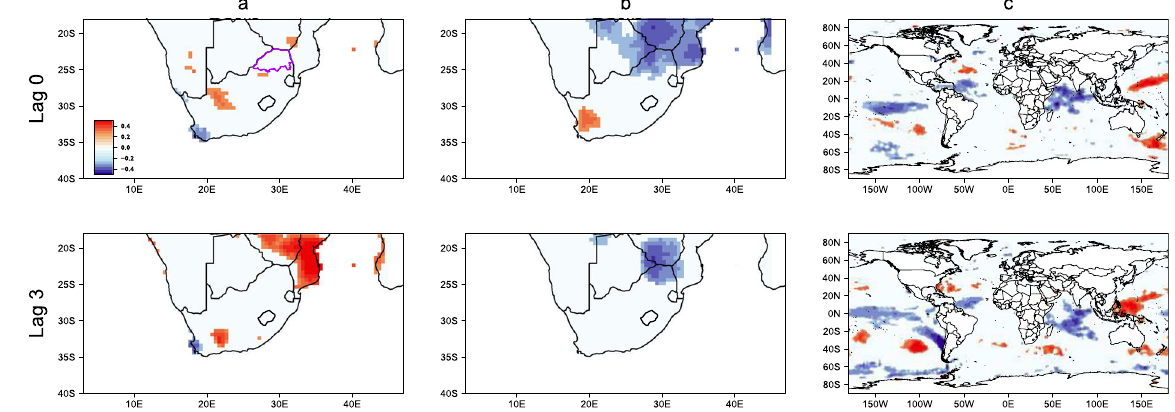
Figure 3. Correlation maps of seasonal malaria incidence in Limpopo and ( a ) precipitation, ( b ) mean temperature, and ( c ) SST anomalies. The top (bottom) row is associated to lags of zero (three) months. The climatic variables are leading the malaria incidence. Correlation coefficients at the 95% confidence level are shown. Figure was made in R version 3.2.2 (https://cran.r-project.org/).